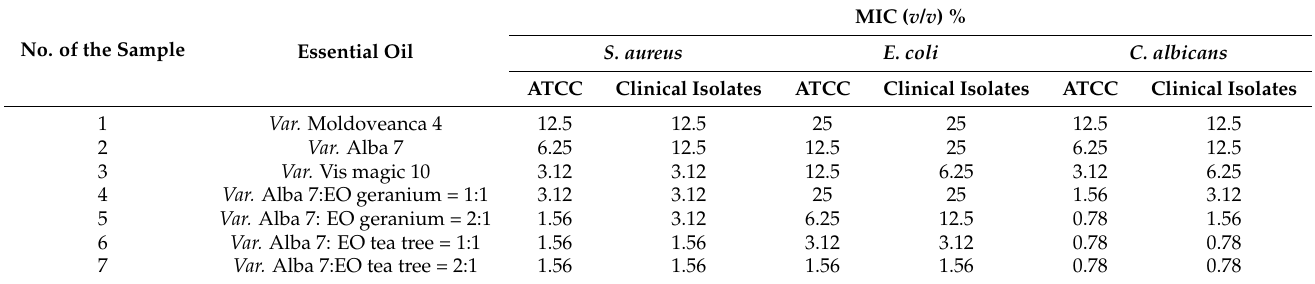
Table 7. Minimum inhibitory concentration (MIC) values of EOs against S. aureus, E. coli, and C. albicans .